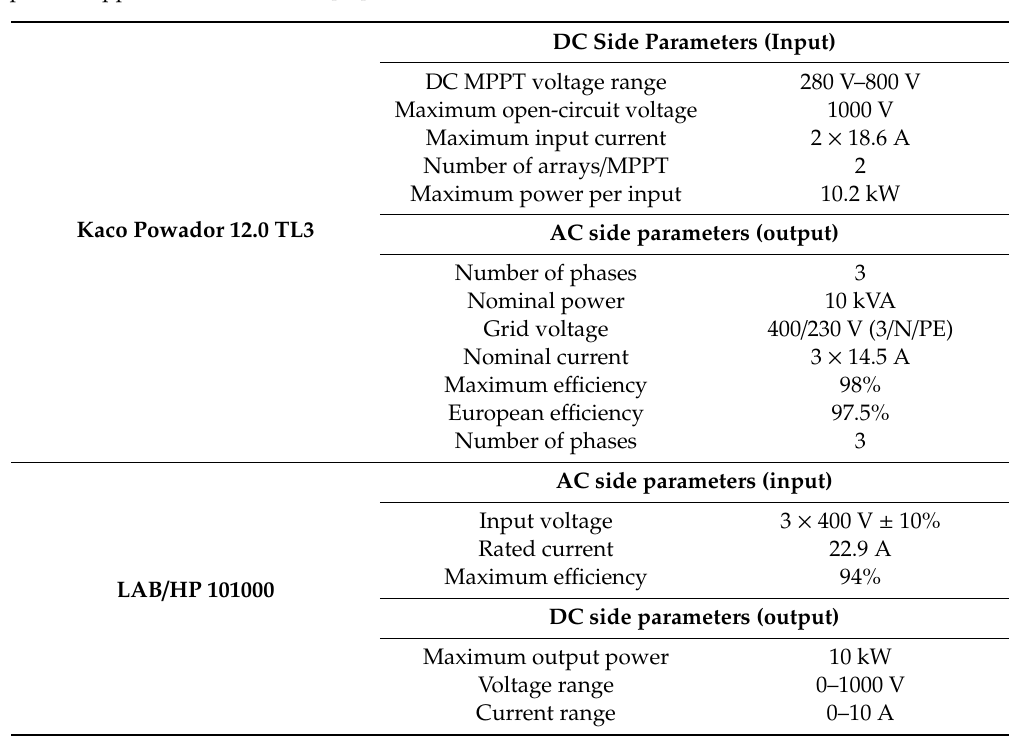
Figure 7. PV emulation system ( a ) made of two DC programmable power supplies ( b ) and a PV plant inverter ( c ). Table 2. Technical characteristics of the Kaco Powador 12.0 TL3 inverter [33] and DC programmable power supplies LAB / HP 101000